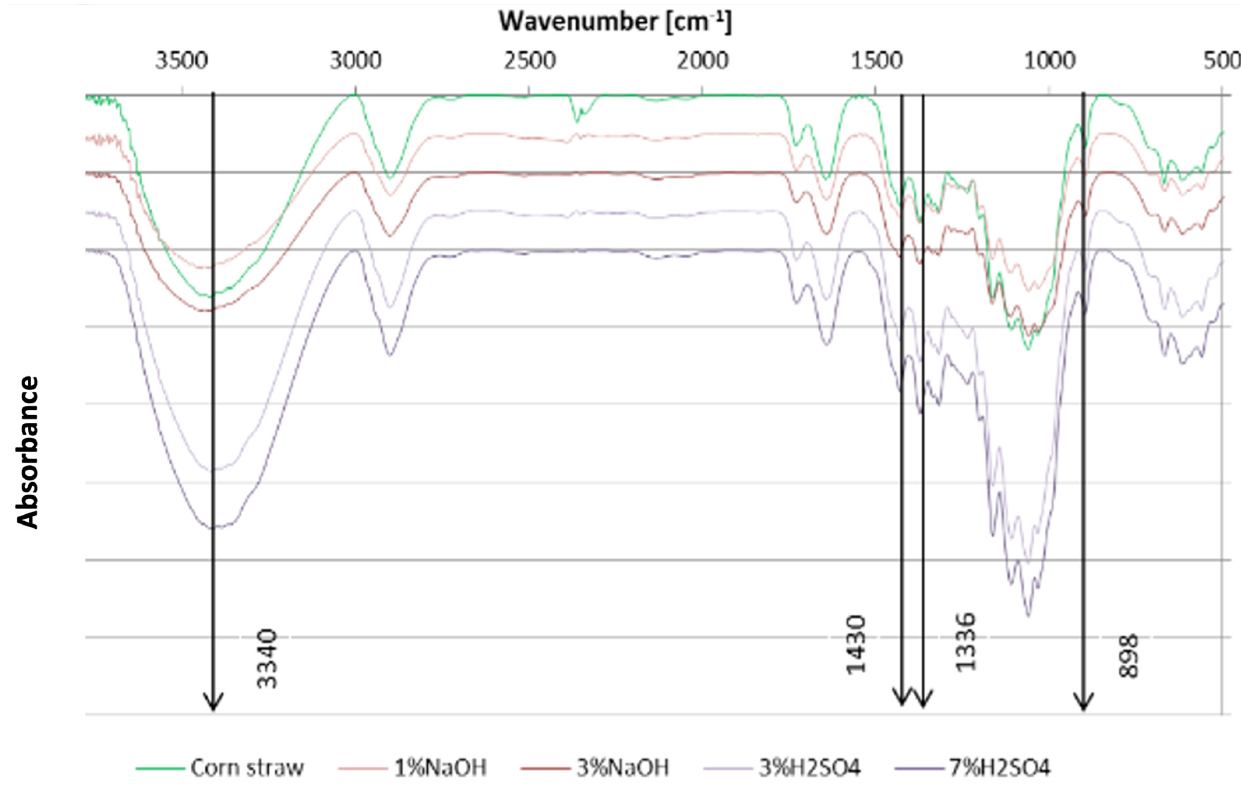
Figure 4. FTIR spectrum of corn straw cellulose before and after pretreatment. Table 2. Parameters of cellulose structure in the tested raw materials after pretreatment. Parameter Pretreatment Populus L.